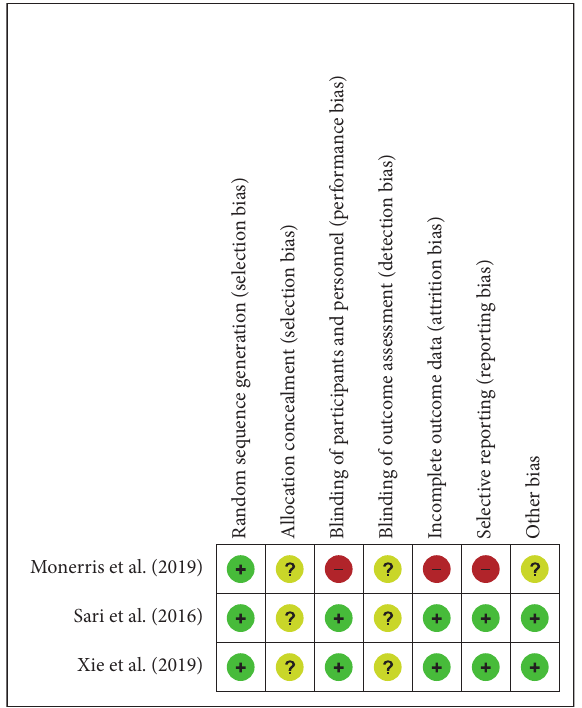
Figure 5: Effect of ultrasound-guided radiofrequency (RF) on the Western Ontario and McMaster Universities Osteoarthritis Index (WOMAC).